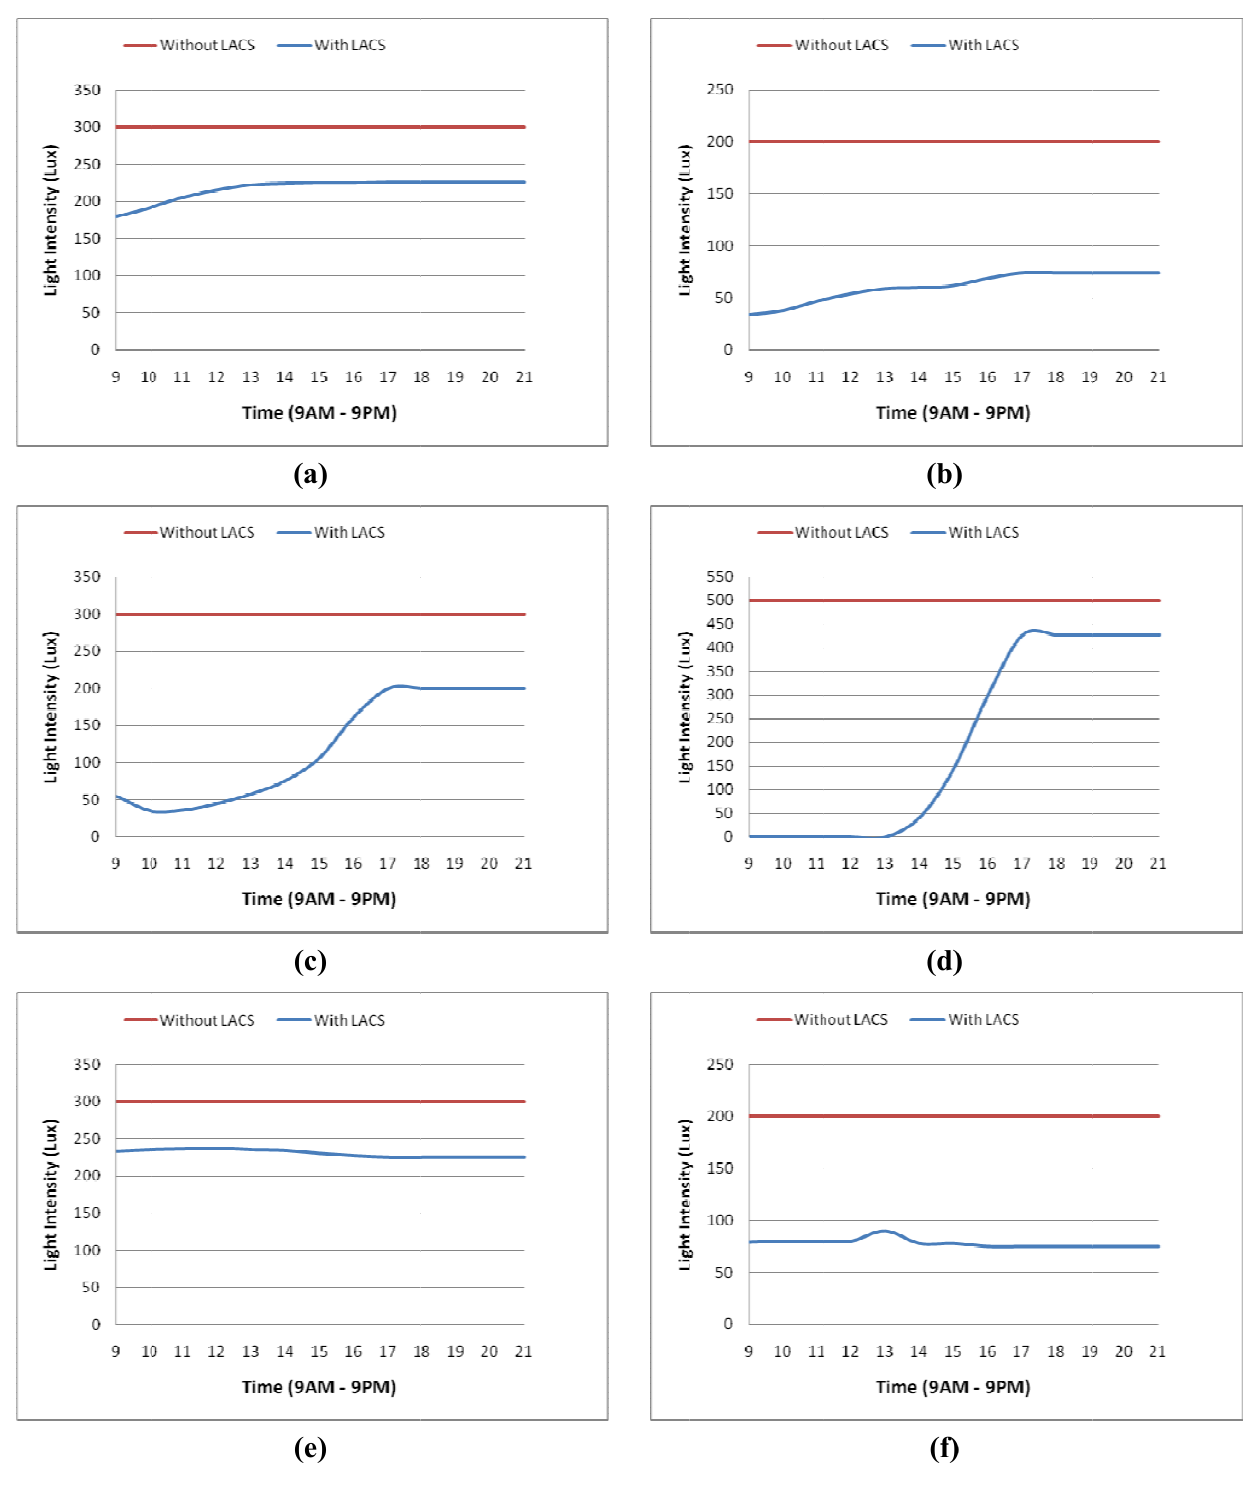
e 9. (a) W (d) WP P4 and Clea overca ast sky;